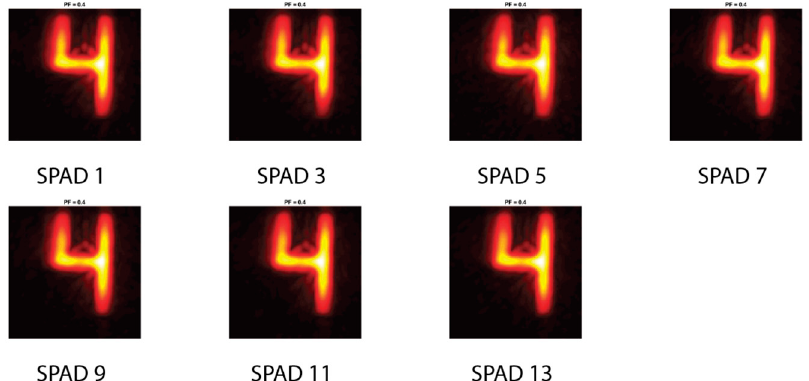
Figure 13. NLOS reconstruction of the hidden object, a number “4” made of white paper (dimensions are 40 × 60 cm 2 ), as seen from the relay wall. Images where acquired by enabling only odd SPADs and overall measurement acquisition time is equal to 8 minutes and we acquired about 4 · 10 7 photons / pixel. Each reconstruction takes approximately 6 minutes.